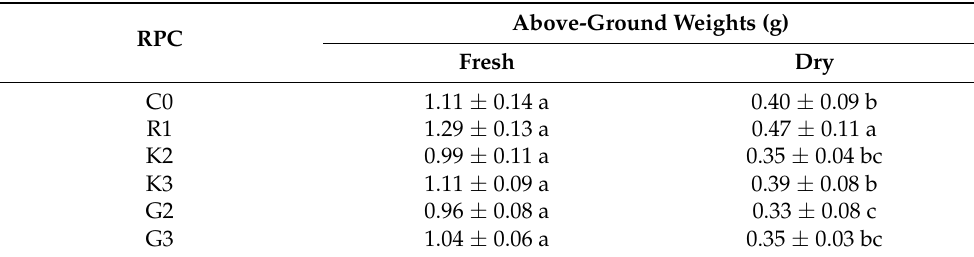
In columns, different letters indicate significant differences within parameters (S.N.K. test, p ≤ 0.05; mean ± SD, n = 3) C0: untreated control; R1: Rhizopon AA (1% IBA); K: Kelpak ® ; G: Goteo ® ; K2: 2 mL L − 1